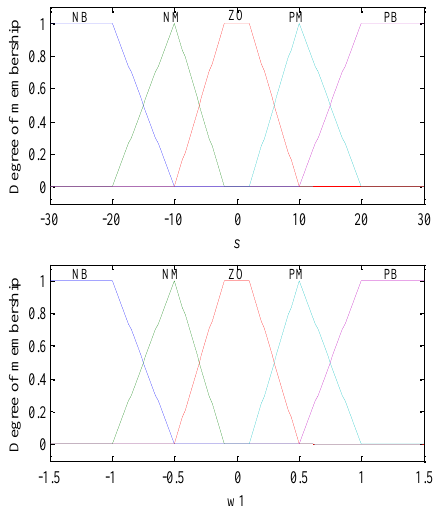
Figure 2. Membership functions of s and w 1.